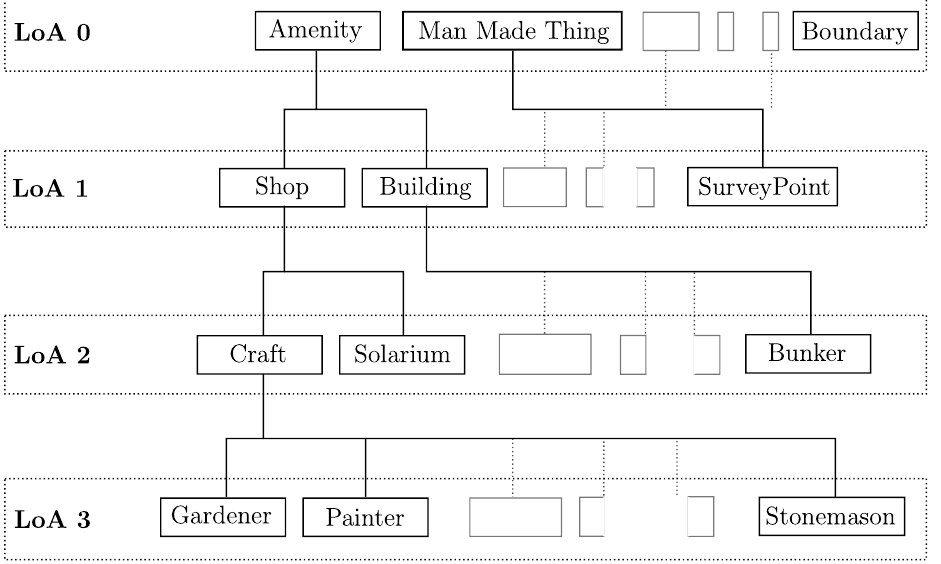
Figure 5. Different examples of OWL classes and to which level of abstractions (LoA) they can belong. The OWL classes exhibit a super- and sub- class relationship to each other. For example, Solarium is a sub-class of Shop which is a sub-class of Amenity . A geo-object which is of type Solarium automatically is of type Shop and Amenity too. This figure illustrates the hierarchical lattice structure of the OWL ontology. In Experiment two , specific LoAs were used to find out how important it is for LULC classification to have more detailed knowledge about